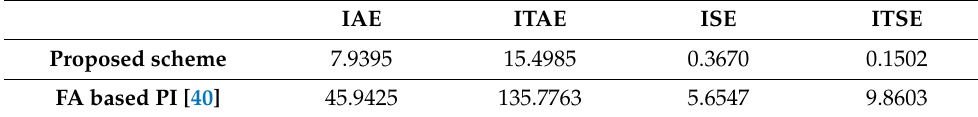
Figure 21. Proportional and integral gains of proposed adaptive controller: ( a ) area 1 and ( b ) area 2 under disturbances in thermal and PV demands. Table 6. Performance indices under disturbances in thermal and PV demands.